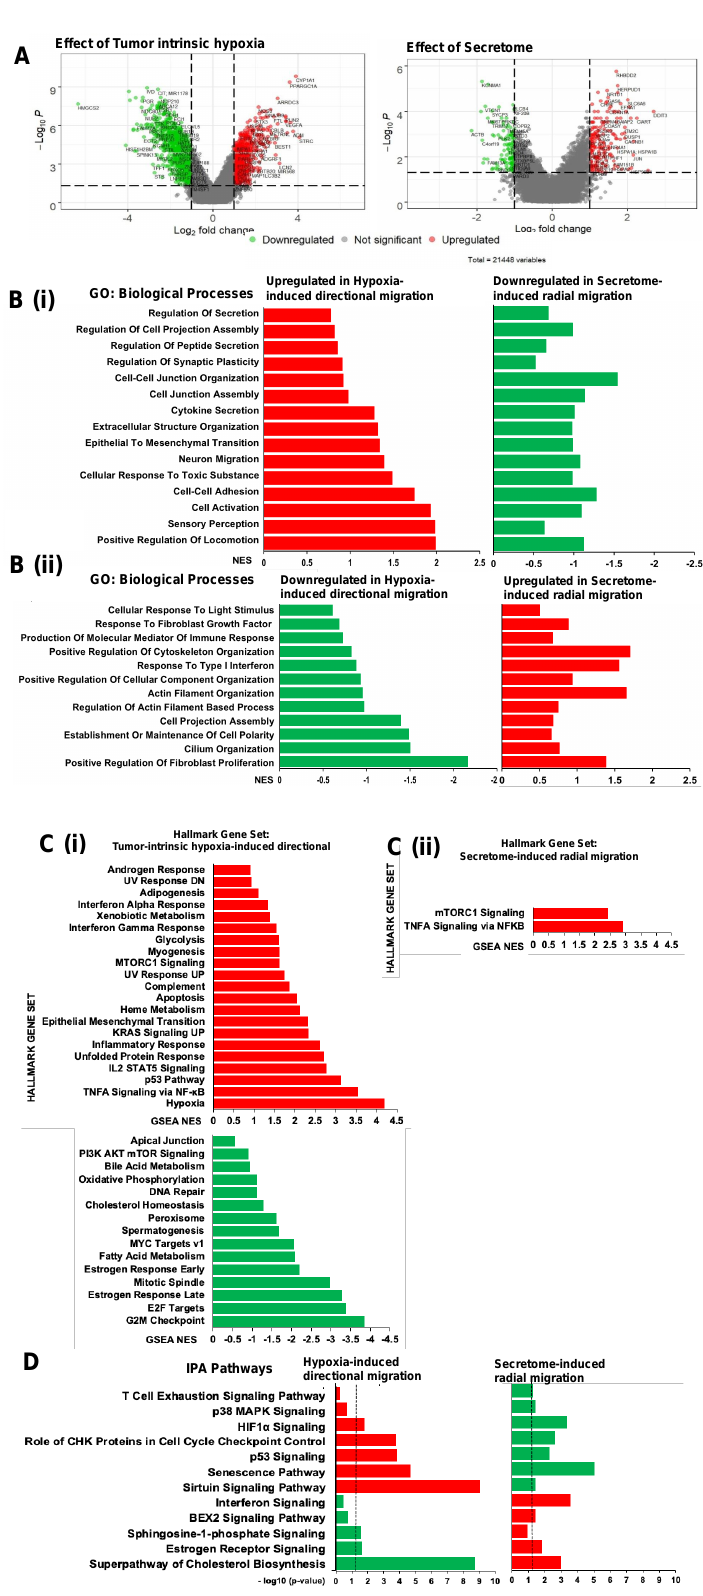
Figure 2. Global changes in gene expression caused by tumor-intrinsic hypoxia and secretome. ( A ) Volcano plots show- ing the significantly upregulated (red) and downregulated (green) genes in tumor intrinsic hypoxia-induced